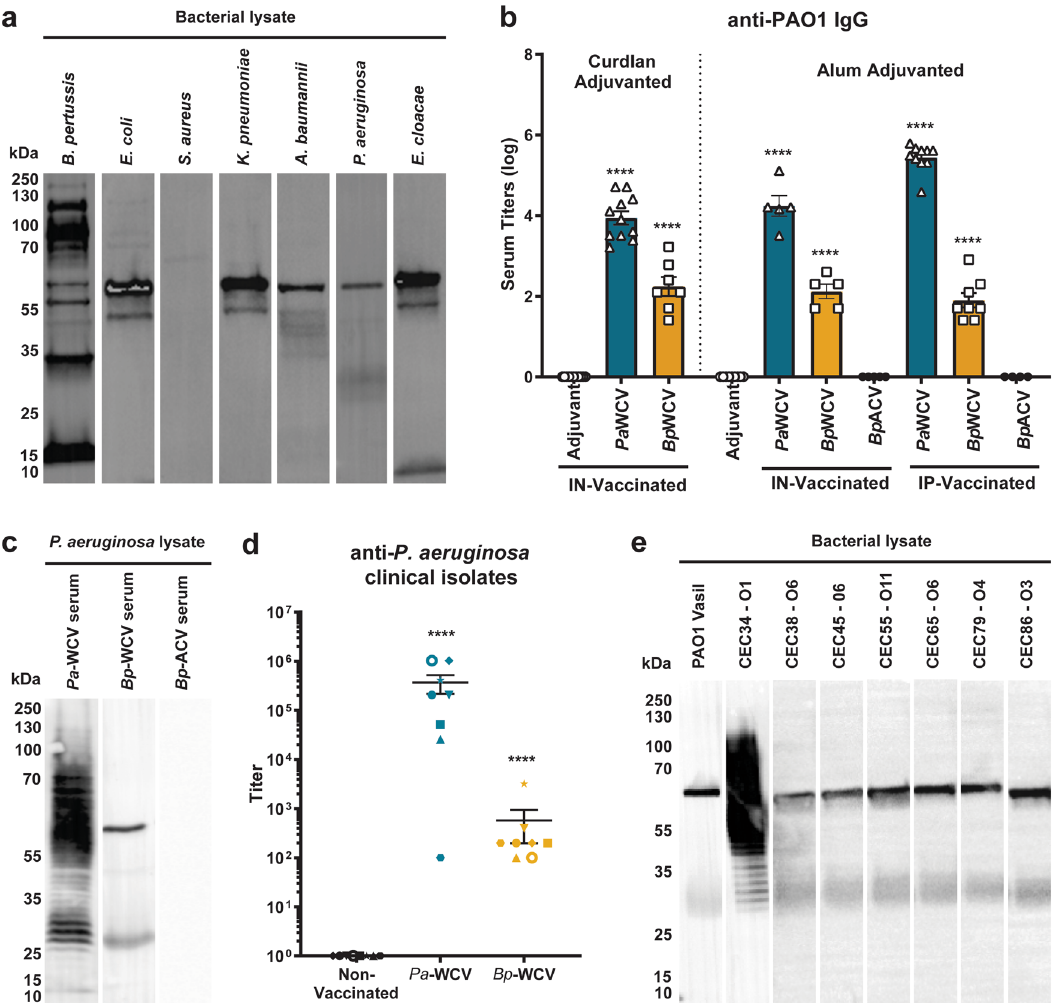
Fig. 1 B. pertussis whole cell but not acellular immunization induces production of cross-reactive antibodies. a Western blot using Bp- WCV immunized sera against 10 μ g of whole cell B. pertussis , E. coli, S. aureus, K. pneumoniae, A. baumannii, P. aeruginosa, and E. cloacae bacterial lysates. All blots in this panel were performed in parallel. b Serum titers determined by ELISA against whole cell P. aeruginosa in mice immunized with adjuvant only, Pa -WCV, Bp -WCV, or Bp -ACV, either intranasally (IN) or intraperitoneally (IP). Each dot represents the average titer for a single mouse ( n = 5 – 11 mice/group), and error bars represent standard error of the mean. c Western blot against P. aeruginosa bacterial lysate using Pa -WCV, Bp -WCV, or Bp -ACV sera from pooled IN and IP immunized mice. d Serum titers determined by ELISA against clinical isolates of P. aeruginosa in mice immunized with adjuvant only, Pa -WCV, or Bp -WCV pooled serum samples. Each unique dot shape represents average titer against a clinical isolate, and error bars represent standard error of the mean. e Western blot against P. aeruginosa clinical isolate bacterial lysate using pooled Bp -WCV immunized sera. All blots in this panel were performed in parallel. In b and d , asterisks represent statistical signi fi cance, determined by one-way ANOVA. Asterisks over bars indicate comparison to the adjuvant vaccinated. **** p <